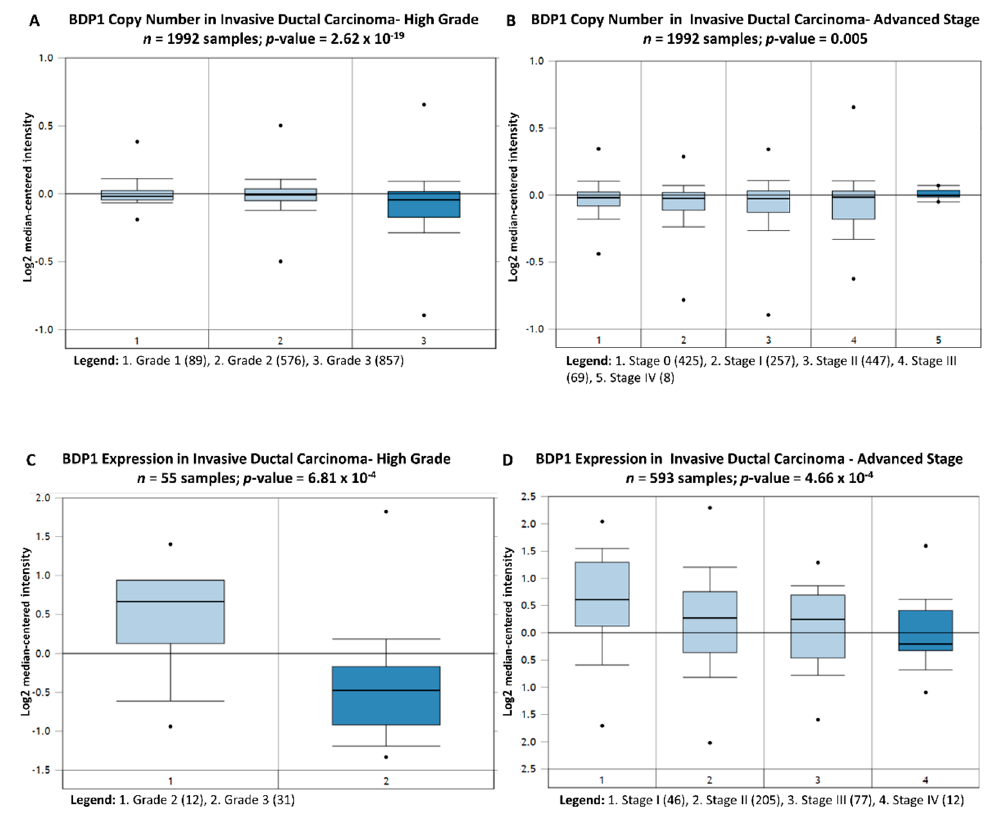
Figure 2. BDP1 copy number and mRNA expression negatively correlate with advanced grade and stage in invasive ductal carcinoma (IDC). ( A ) BDP1 copy number is significantly decreased in the Curtis breast dataset [40], n = 1992 samples and p -value = 2.62 × 10 − 19 . The gene rank for BDP1 under-expression is in the top 1% (66) of 18,823 measured genes in IDC, high grade. Using the same Curtis Breast dataset [40], ( B ) BDP1 copy number is also significantly decreased in advanced stage IDC, p -value = 0.005. The gene rank for BDP1 is in the top 3% (547) of 18,823 measured genes in IDC, advanced stage. ( C ) BDP1 expression is significantly decreased in the Ginestier breast dataset [52], n = 55 samples and correlates with high grade IDC, p -value = 6.81 × 10 − 4 . The gene rank for BDP1 under-expression is in the top 1% (193) of 19,574 measured genes in IDC, high grade. ( D ) BDP1 expression significantly decreases in the TCGA breast dataset [45–47], n = 593 samples and p -value = 4.66 × 10 − 4 . The gene rank for BDP1 under-expression is in the top 1% (120) of 20,423 measured genes in IDC, advanced stage. Bright blue denotes statistically significant BDP1 changes. The Oncomine™ Platform (Thermo Fisher, Ann Arbor, MI, USA) was used for analysis and visualization.